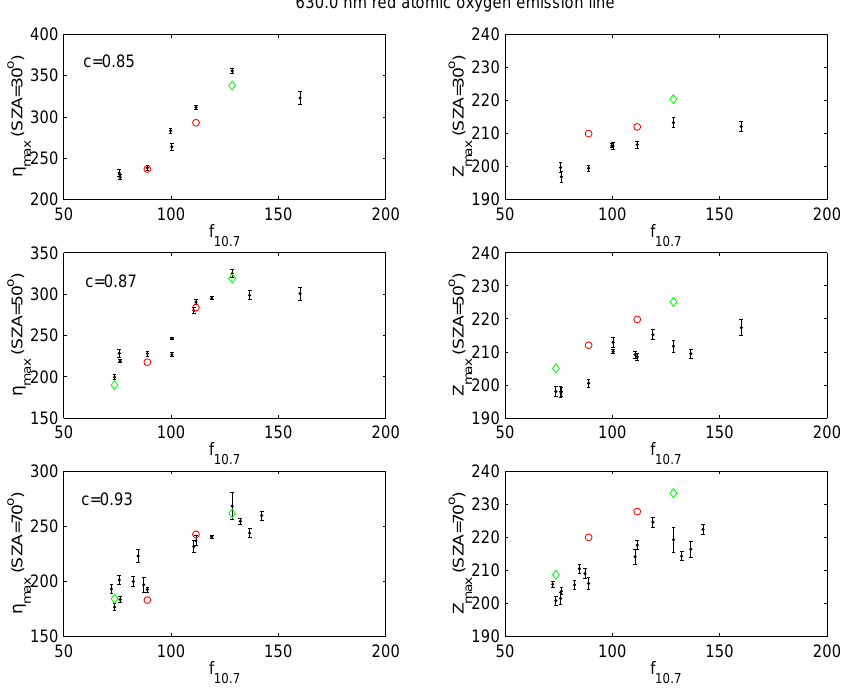
Fig. 11. WINDII measurements of the 630.0nm volume emission rates and maximum emission altitudes for quiet geomagnetic days ( A p ≤ 10), from 1992 to 1995. Data are plotted versus the f 10 . 7 index, and error bars correspond to the standard deviation. Diamonds correspond to the TRANSCAR simulation results presented in Sect. 4.1.1, and circles are simulations results for intermediate solar activity.